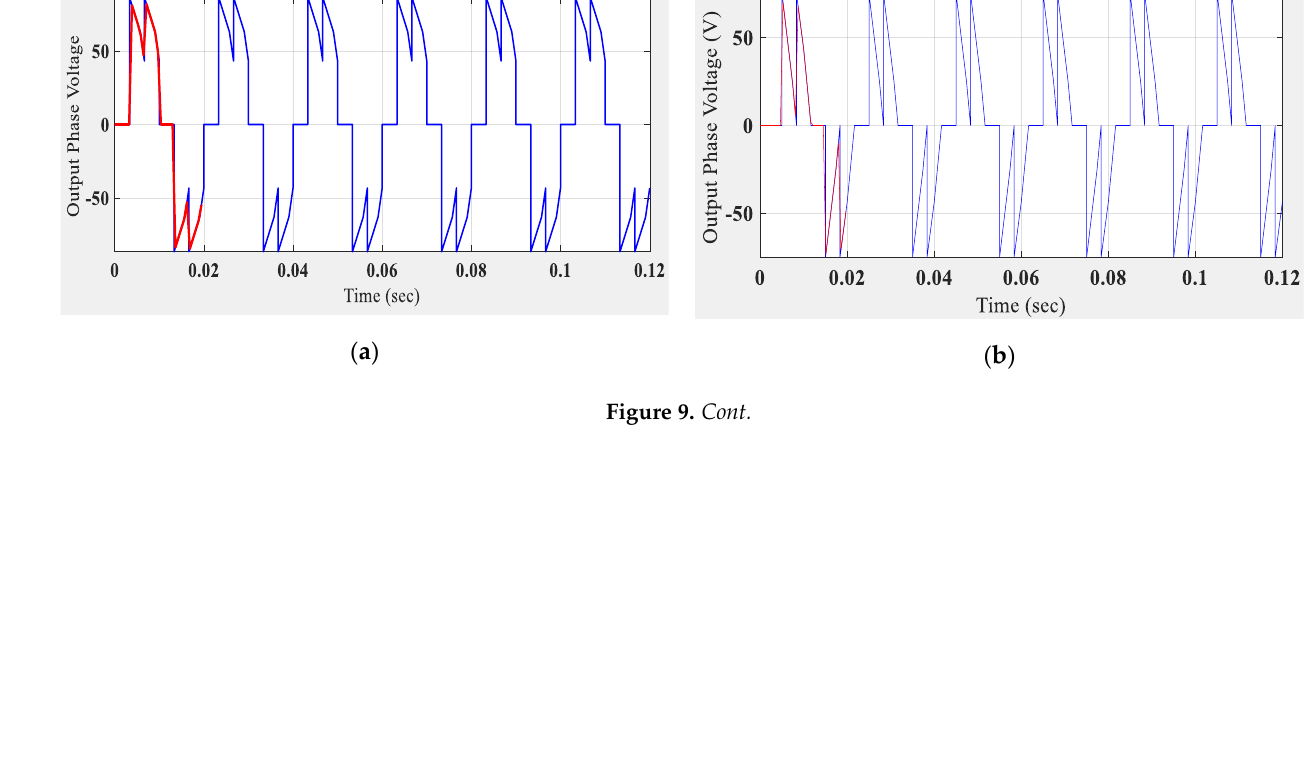
20 of 27 Table 5. Harmonic coefficients of output voltage control with PWM control.